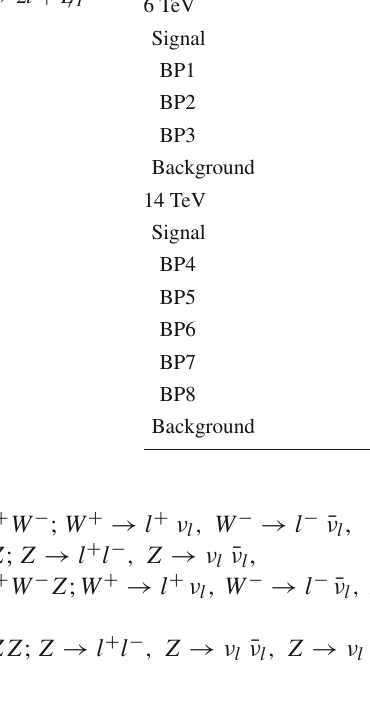
Table 3 The LO cross sections for signal and backgrounds for the process μ + μ − → 2 l + E T / at 6 TeV and 14